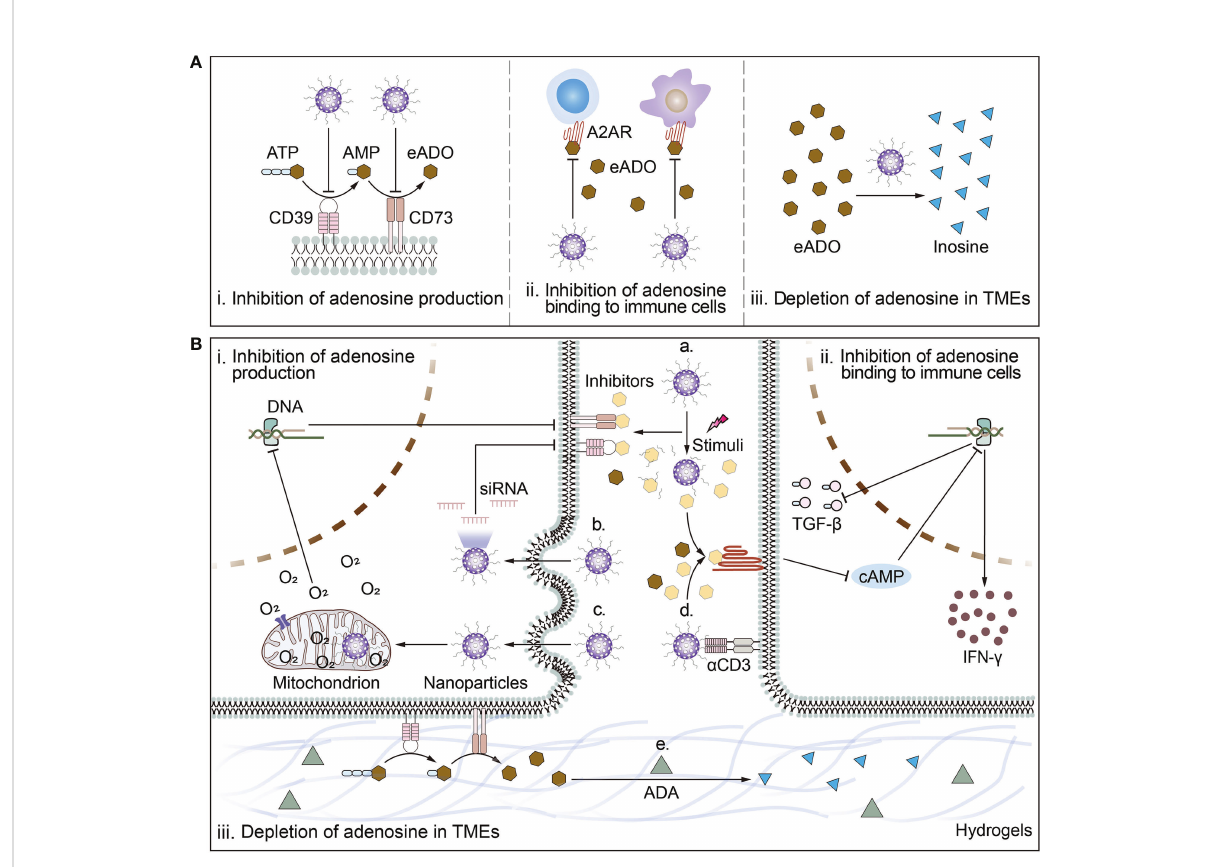
FIGURE 2 Schematicillustrationofbiomaterial-basedstrategiestotargetadenosineinTMEsanddeepmechanisms. (A) Biomaterial-basedstrategiestotargetadenosine includei)inhibitionofadenosineproduction;ii)inhibitionofadenosinebindingtoimmunecells;andiii)depletionofadenosineinTMEs. (B) Themechanismsof biomaterial-basedstrategiestotargetadenosine.Mechanismsbywhichbiomaterialsinhibitadenosineproductionincludea)responsivereleaseofinhibitorsofCD39 orCD73;orb)reductionofATP-convertingenzymereceptorexpressionlevelsbydeliveryofsiRNAforCD73orCD39andc)ameliorationofcellularhypoxia. Mechanismsbywhichbiomaterialsinhibitadenosinebindingtoimmunecellsincludea)responsivereleaseofinhibitorsofA2ARord)surfacemodi fi cationofligands targetingimmunecellsincloseproximitytoreleaseantagoniststoblockthebindingofadenosinetoA2AR.Mechanismbywhichbiomaterialsdepleteadenosine